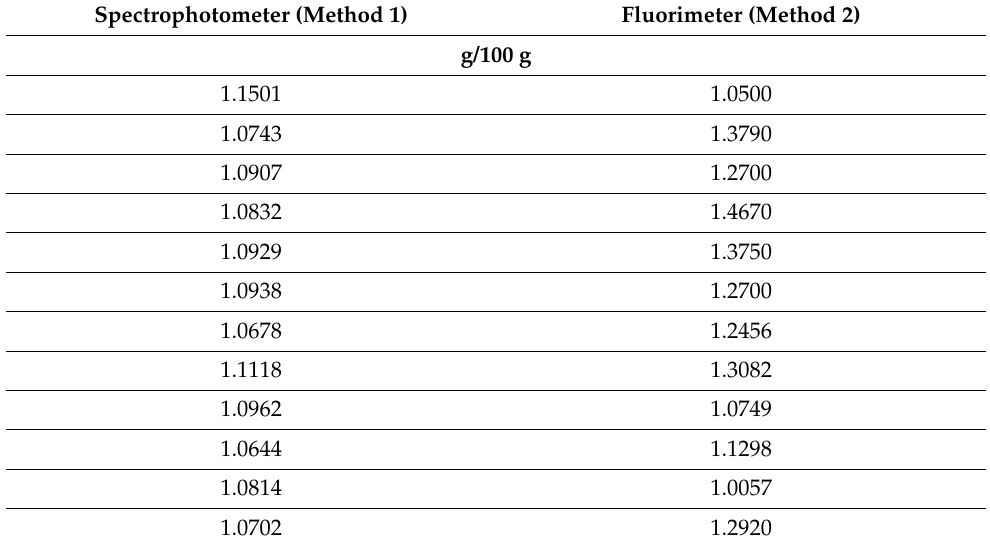
Table 2. Results comparison between the 2 analytical methods.